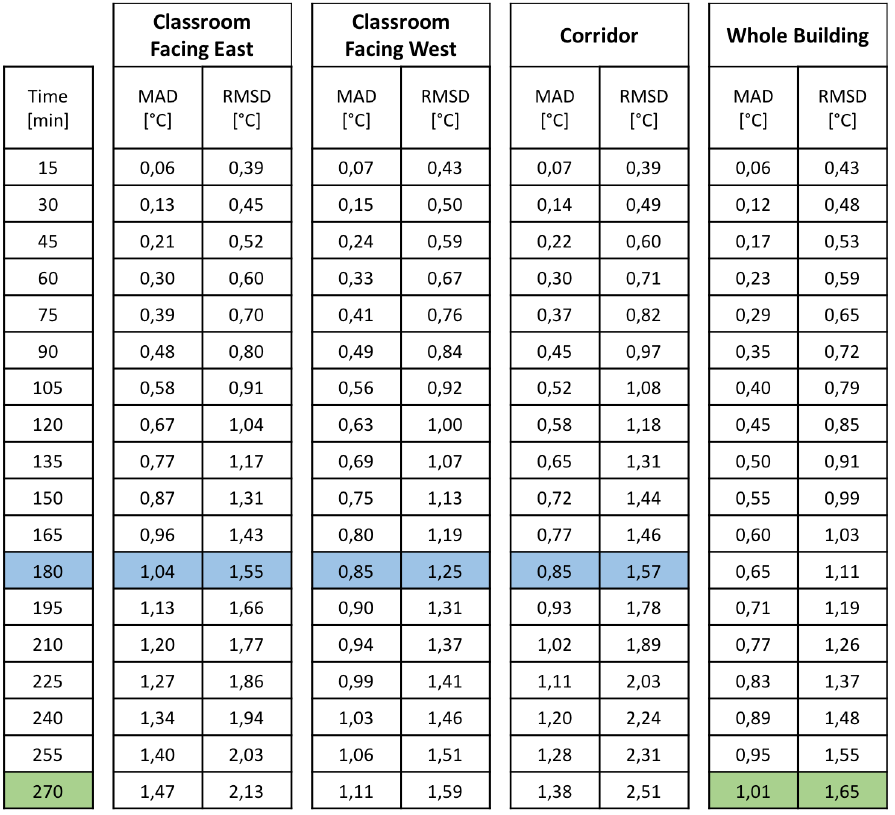
Figure 5. Prediction performance on the simulated dataset. Blue and green lines correspond to the maximum prediction horizons that guarantee acceptable thermal comfort, respectively for the individual rooms and the whole building